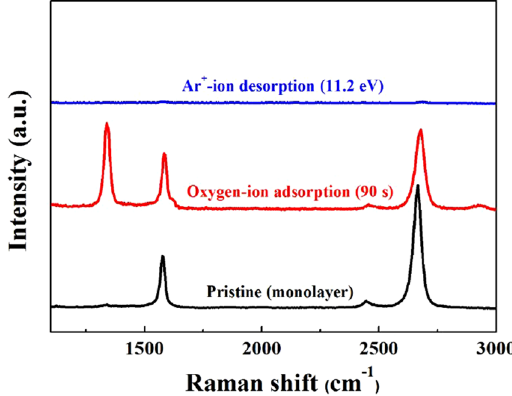
Figure 4. Raman spectra of pristine monolayer graphene by optimized oxygen-ion adsorption step and Ar + - ion desorption step. The monol ayer graphene chemically adsorbed with the optimized oxygen-ion for 90 s, and the chemisorbed monolayer graphene sequentially exposed to the optimized Ar + -ion for physical desorption for 120 s and which resulted in complete etching of one monolayer